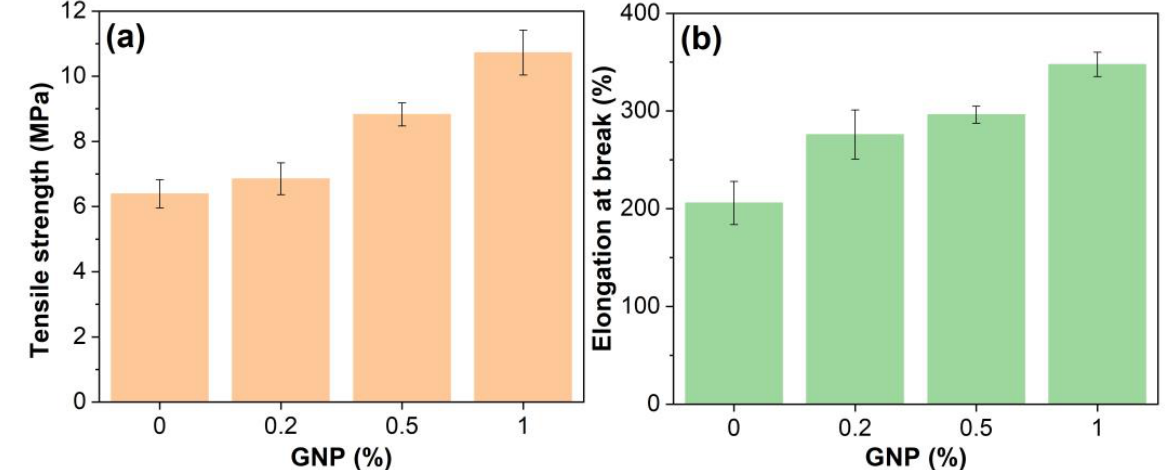
Figure 10. Tensile strength ( a ) and elongation at break ( b ) of GNP-reinforced EABCs. In a tensile test, the integral of the stress ( σ ) vs. strain ( ε ) curve indicates the toughness ( τ ) of the material [57,58]. Thus,